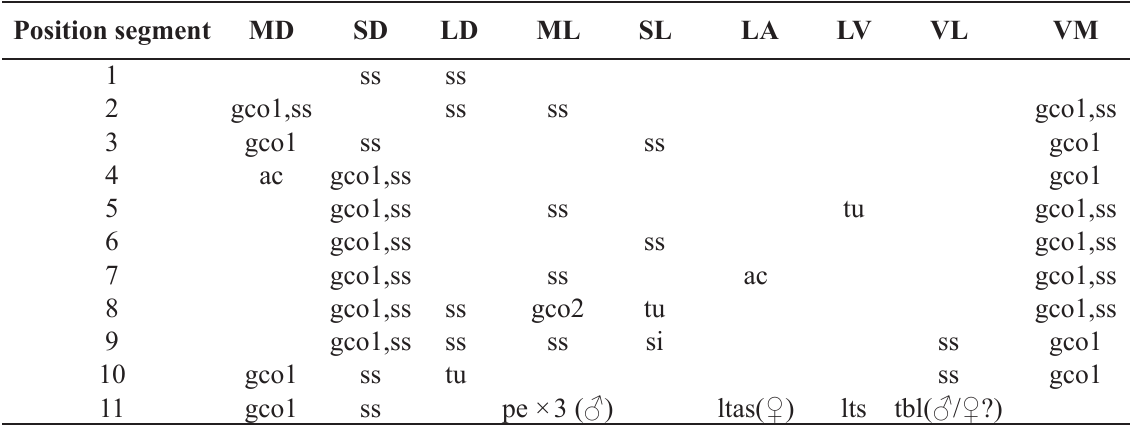
Table 3. Summary of nature and location of sensory spots, glandular cell outlets, tubes and spines arranged by series in Echinoderes blazeji sp.